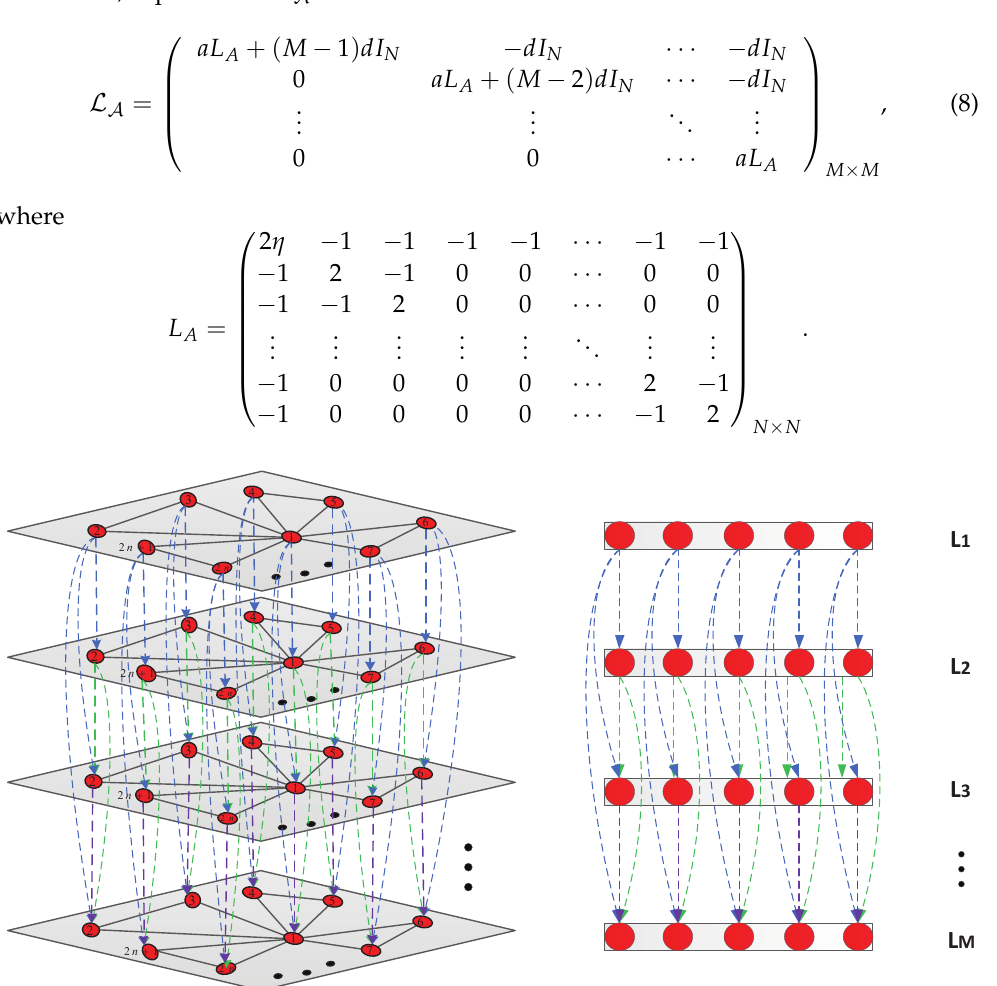
Figure 2. Structure schematic diagram of Networks-A with M